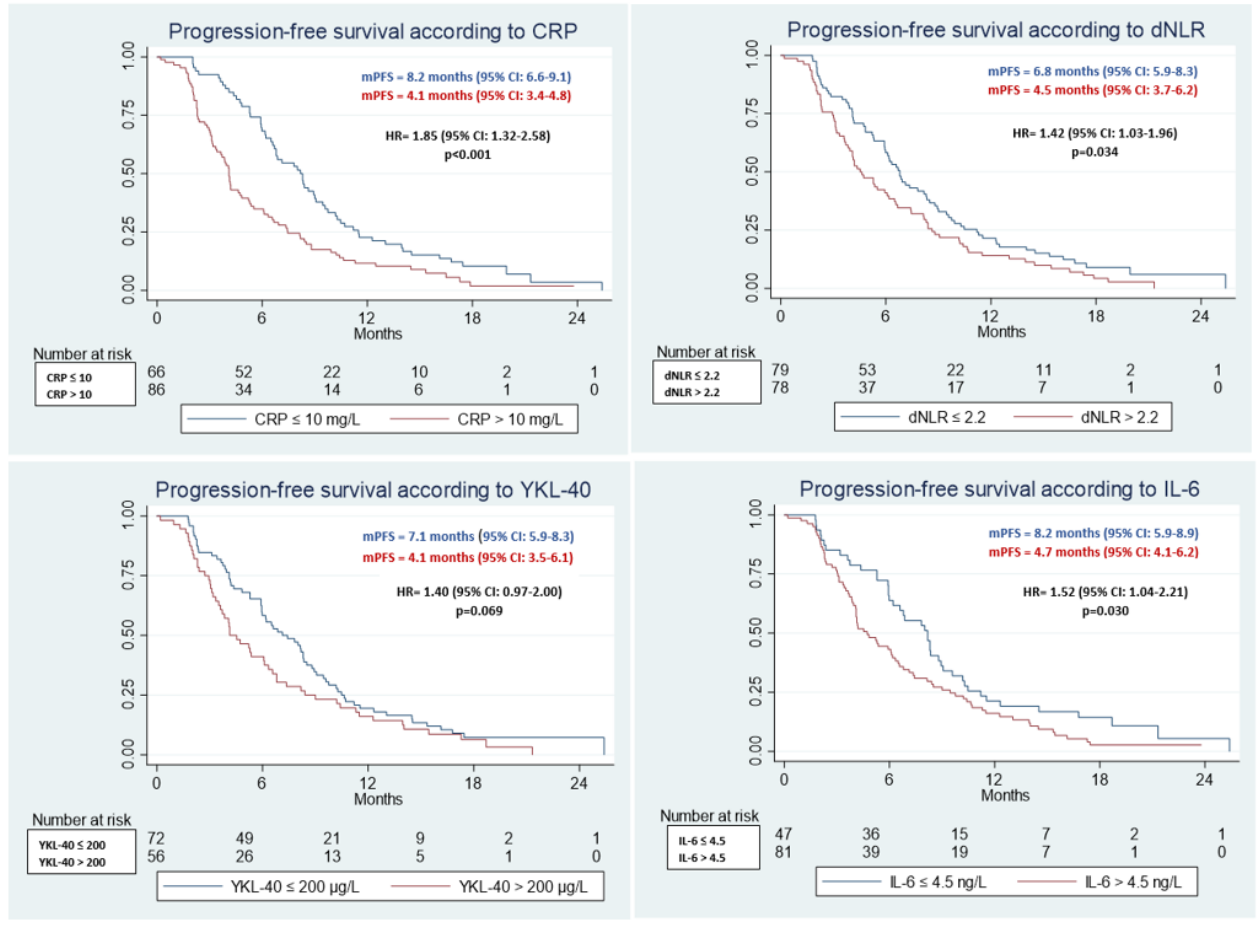
Figure 3. Kaplan-Meier plots showing baseline dichotomized biomarker (normal/high) associations with progression-free survival.